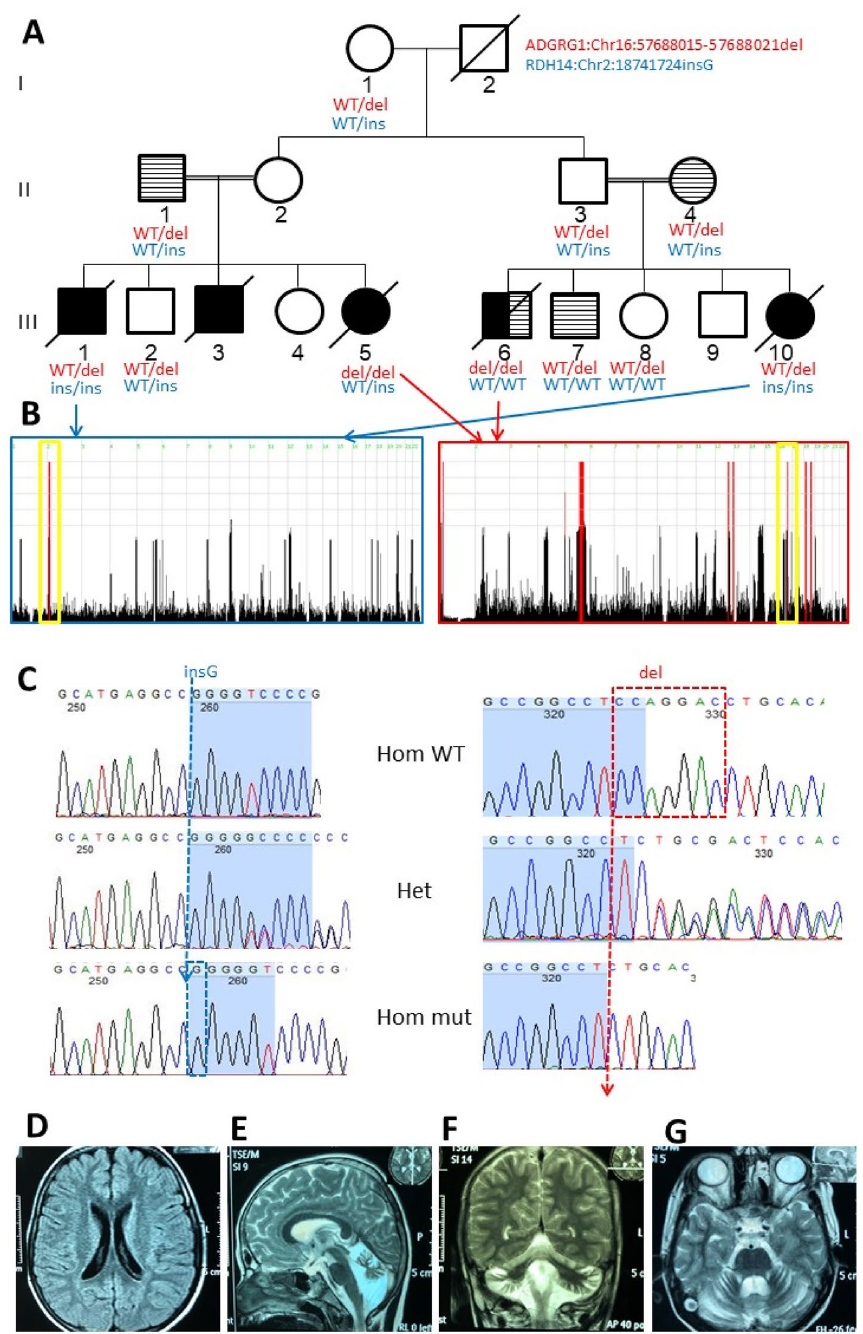
Figure 1. Homozygosity mapping and ADGRG1 / RDH14 mutations in Pakistani intellectual disability/hyperkeratosis family. ( A ) Pedigree drawing focusing on branches with ID. Additional branches with individuals with hyperkeratosis have been trimmed. Individuals II-1 and II-4 are siblings, whose mother was sibling of I-1, and are first cousins of II-2 and II-3. Dark shaded shapes represent a diagnosis of ID, and hashed shading indicates autosomal dominant hyperkeratosis. III-6 has both diagnoses; ( B ) Homozygosity Mapper 23 output for Illumina Human CoreExome genotypes, left, using III-1 and III-10 as cases, and III-2, III-5, III-6, III-7, III-8 as controls, and right, using III-5 and III-6 as cases, and III-1 and III-11, III-2, III-7, III-8, and III-10 as controls. HBD regions are listed in Table 1. Whole exome sequencing (WES) identified a known disease-causing mutation in the gene for bilateral frontoparietal (BFPP) gene ADGRG1 (also known as GPR56 ), within the HBD region on chromosome 16 (indicated in a yellow box), and segregating just for individuals III-5 and III-6. WES also identified loss of function mutations in RDH14 , within the sole HBD region for the remaining affecteds, III-1 and III-10. ( C ) Representative electropherograms for RDH14 (left) exon 1, and ADGRG1 exon 5, for homozygous wild type (hom WT), heterozygous (het) and homozygous mutant (hom mut) genotypes. ( D – G ) Magnetic resonance imaging of RDH14 mutation homozygote individual III:1: ( D ) Axial FLAIR image showing normal cerebral white matter; ( E ) Sagittal T2 image showing marked volume loss of the cerebellar vermis, with associated ex-vacuo dilatation of the 4th ventricle. ( F ) Coronal T2 image showing severe cerebellar atrophy, including the lateral cerebellar hemisphere. Note preserved cerebral volume. ( G ) Axial T2 image showing marked volume loss of the cerebellum, with associated ex-vacuo dilatation of the 4th ventricle. Note preserved brainstem